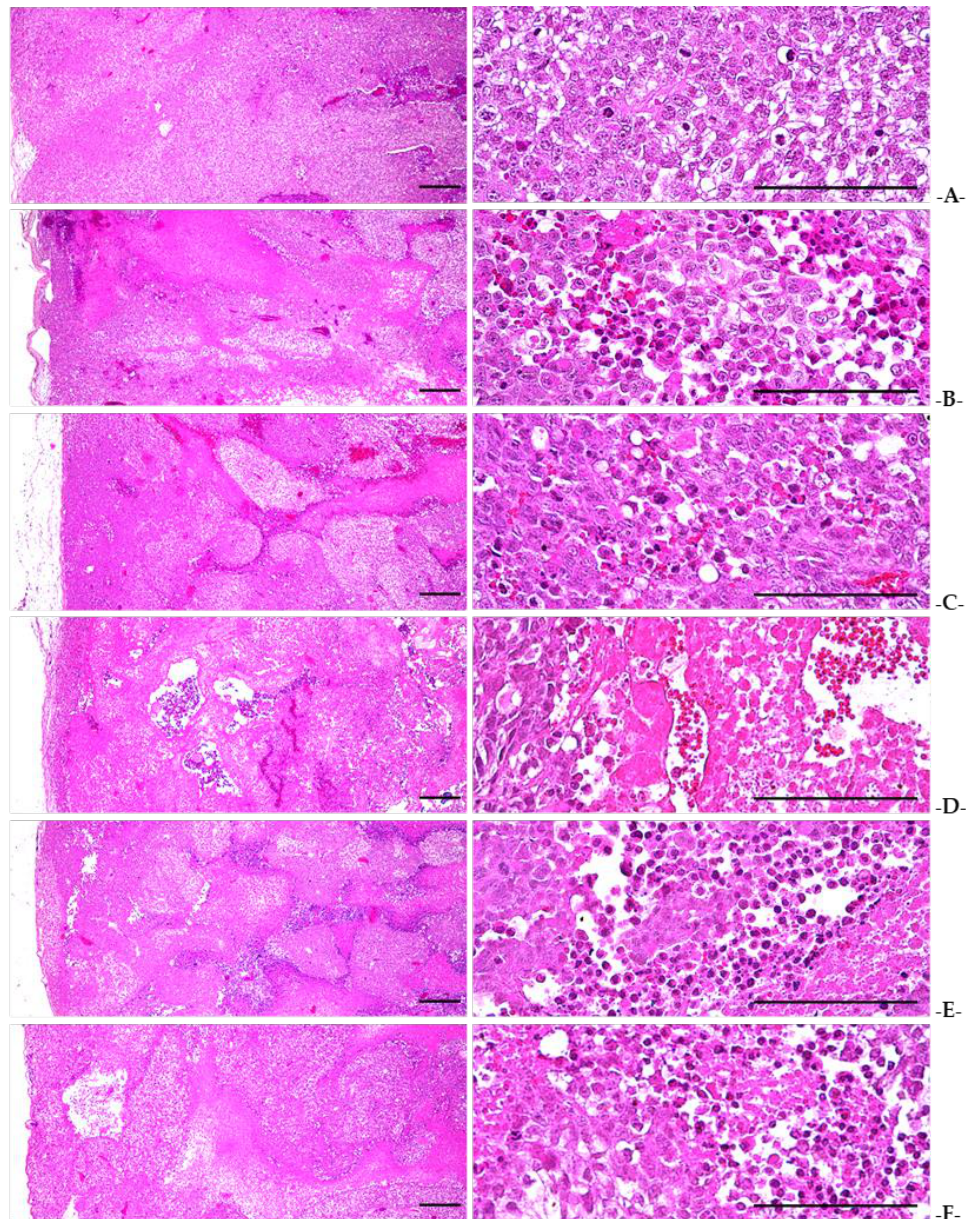
Figure 7. Representative histological profiles of the tumor masses taken from NCI-H520 tumor cell xenograft mice. ( A ) = Tumor-bearing control; ( B ) = 120 mg/kg-gefitinib-single-treated rodents; ( C ) = 400 mg/kg-SKOG-single-treated rodents; ( D ) = gefitinib 120 mg/kg and SKOG 400 mg/kg; ( E ) = gefitinib 120 mg/kg and SKOG 200 mg/kg; ( F ) = gefitinib 120 mg/kg and SKOG 100 mg/kg. AR = Adenophorae Radix; KOG = Kyeongokgo ; SKOG = sasam-Kyeongokgo . All Hematoxylin-Eosin-stained. Scale bars = 100 μm.